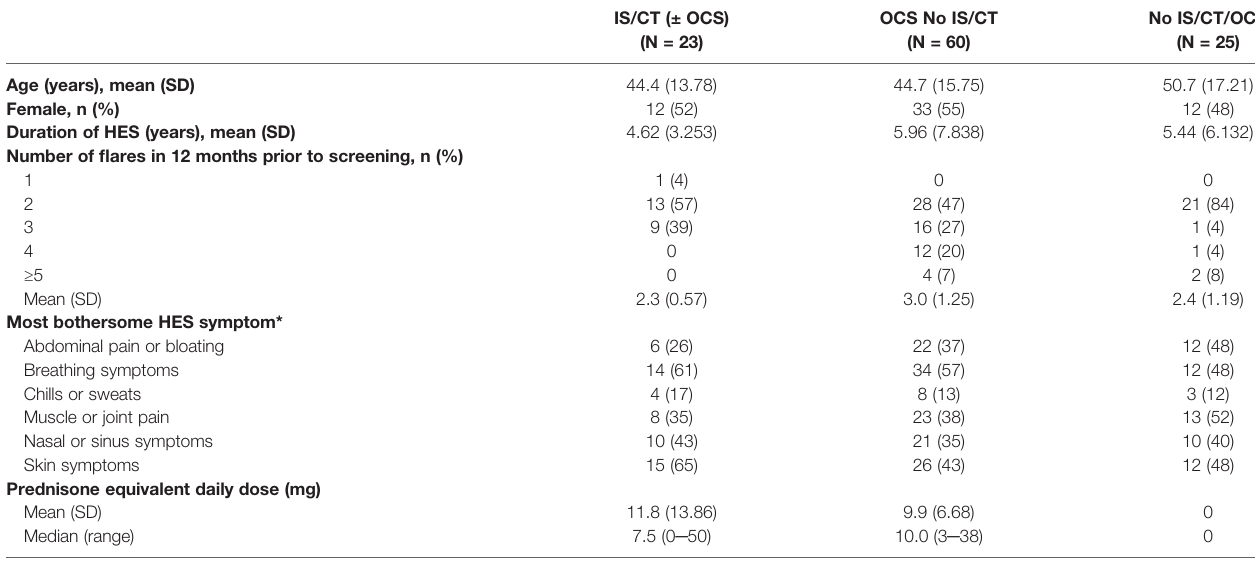
TABLE 2 | Baseline demographics and clinical characteristics in the ITT population by baseline treatment type.